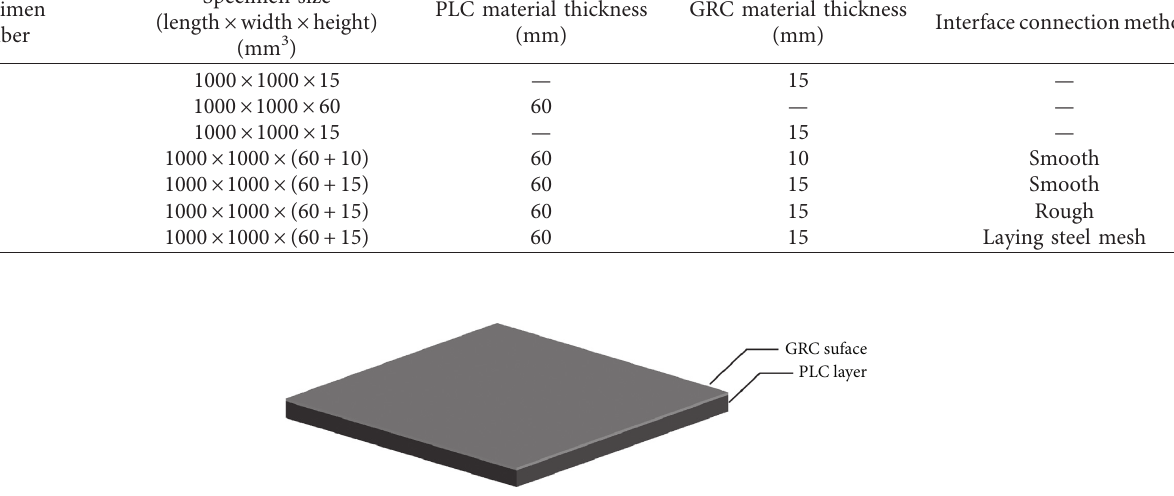
Figure 4: GRC-PLC composite